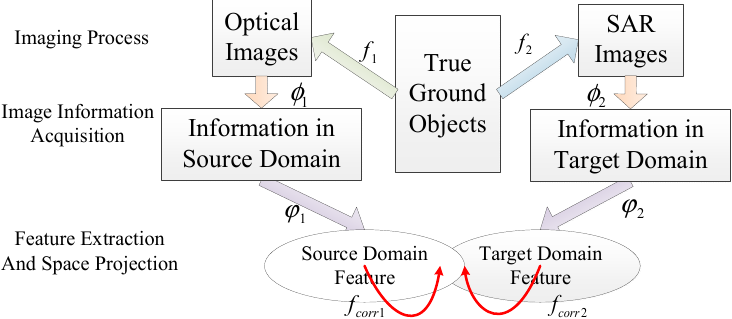
Figure 3. The processes from the real object to learning features.